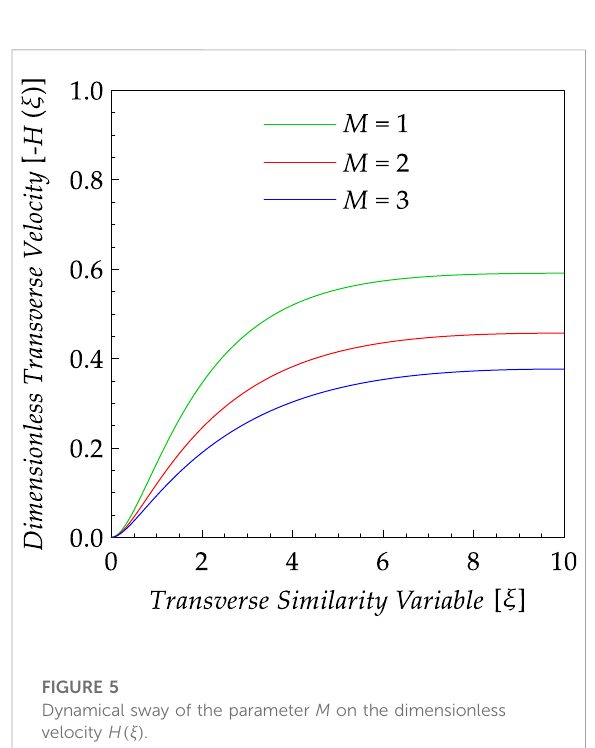
FIGURE 7 Thermal in fl uence of the parameter Q E on the dimensionless temperature Θ ( ξ ) .